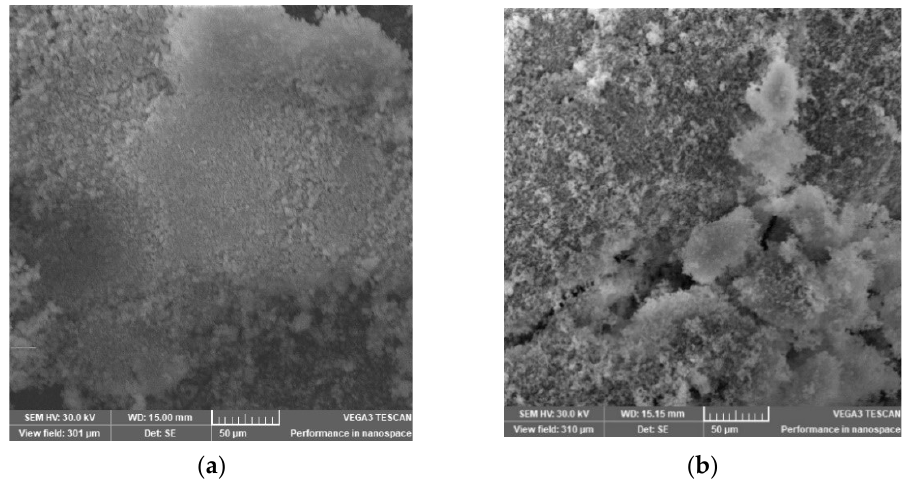
Figure 8. SEM images of: ( a ) biofilm of sample S9 and ( b ) biofilm of sample S10 .